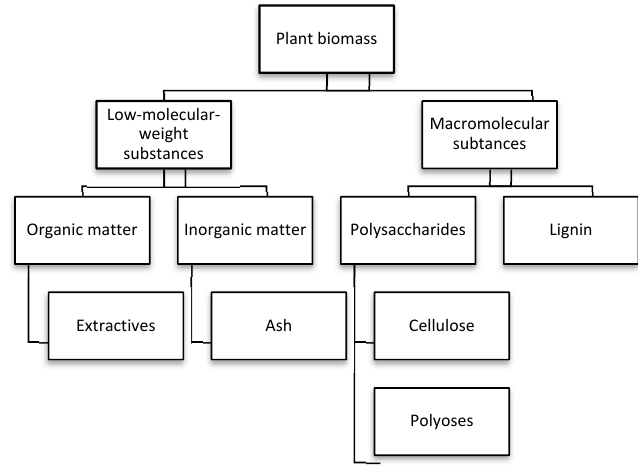
Figure 3. General components in biomass produced from short rotation woody crops [100].